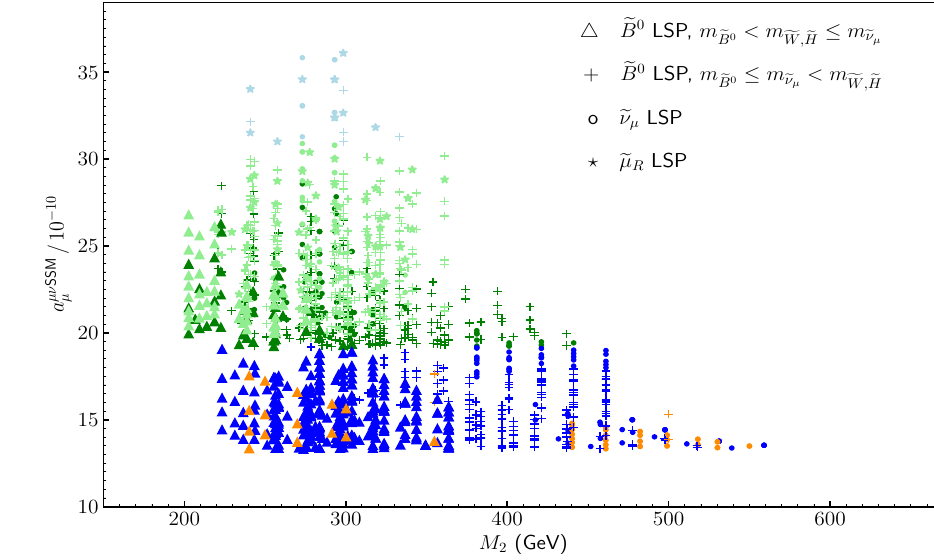
Fig. 9 The same as in Fig. 8, μν SSM but showing a μ versus M